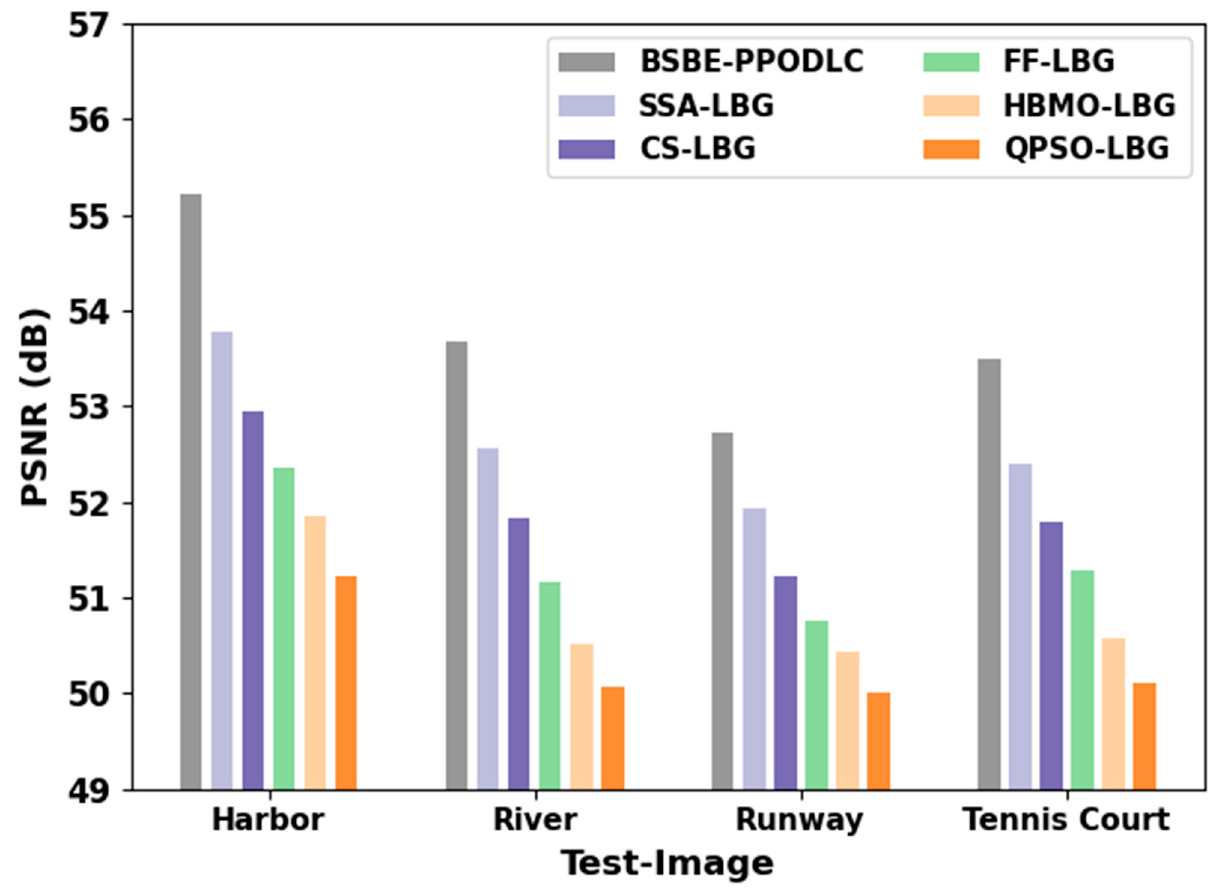
Figure 5. MSE analysis results of the BSBE-PPODLC approach under distinct test images. In Figure 6, the RSI classification results attained by the proposed BSBE-PPODLC model are presented in the form of a confusion matrix. The results specify that the pro- posed BSBE-PPODLC method effectively identified four classes.